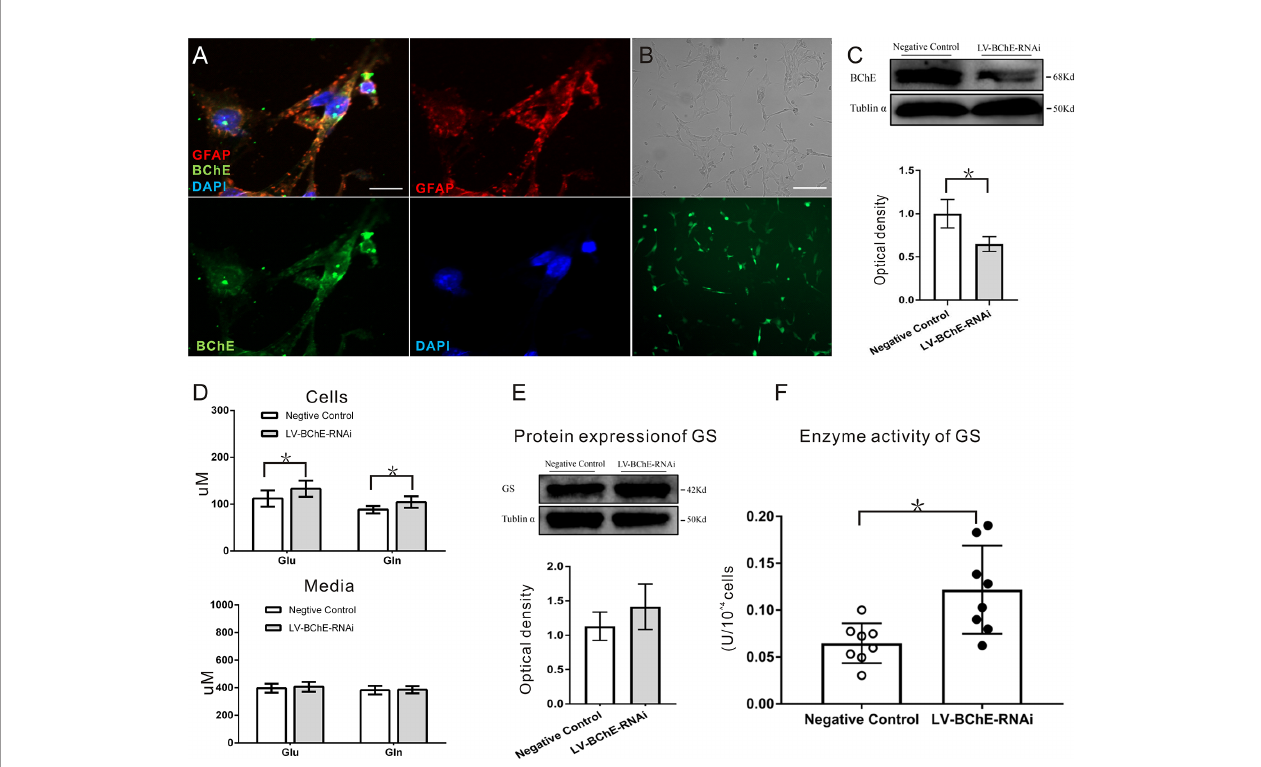
FIGURE 6 | In vitro BChE knockdown in astrocytes increased both Glu and Gln levels and GS enzyme activity. (A) Colocalization of the astrocyte marker GFAP (red) and BChE (green) was detected in C8D1A cells, Scale bar: 20 µm). (B) Representative images of EGFP expression 72 h after C8D1A cells were transfected with lentivirus. Scale bar: 200 m m. (C) Western blots probed with anti-BChE and anti-tubulin a antibodies. The expression of BChE was signi fi cantly decreased 72 h after lentivirus transfection in the LV-BChE-RNAi group compared with the negative control group ( p = 0.031, * p < 0.05; n = 3). (D) The results showed that both Glu and Gln levels were increased when BChE expression was downregulated (Glu: p = 0.036; n = 6 – 8; Gln: p = 0.010; n = 8; * p < 0.05). However, the data showed that the concentrations in the medium were not signi fi cantly different between the negative control and LV-BChE-RNAi groups (Glu: p = 0.566; n = 8; Gln: p = 0.834; n = 8). (E) Representative western blot images of GS expression in C8D1A cells after BChE knockdown are shown. The protein expression of GS was not signi fi cantly changed after BChE knockdown in the LV-BChE-RNAi group compared with the negative control group ( p = 0.275, n = 3). Relative intensity: GS/tubulin a . (F) BChE knockdown signi fi cantly increased the enzyme activity of GS in C8D1A cells in the LV-BChE-RNAi group compared with the negative control group ( p = 0.003, * p < 0.05; n = 8). The data are presented as the mean ±